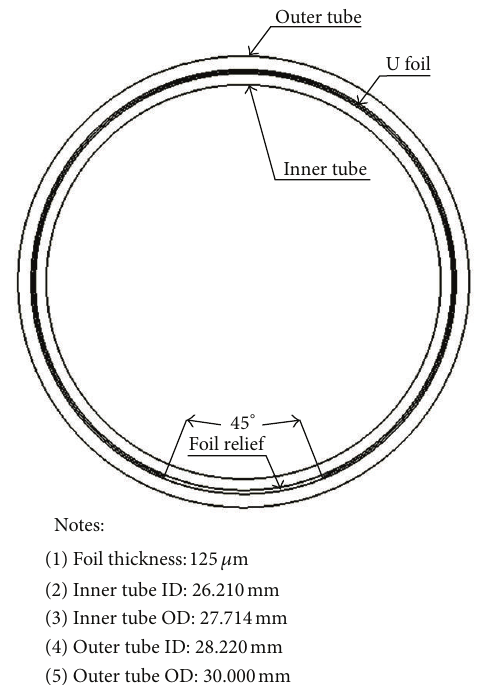
Figure 3: Drawing of the geometry used for the assembly model in the first analysis